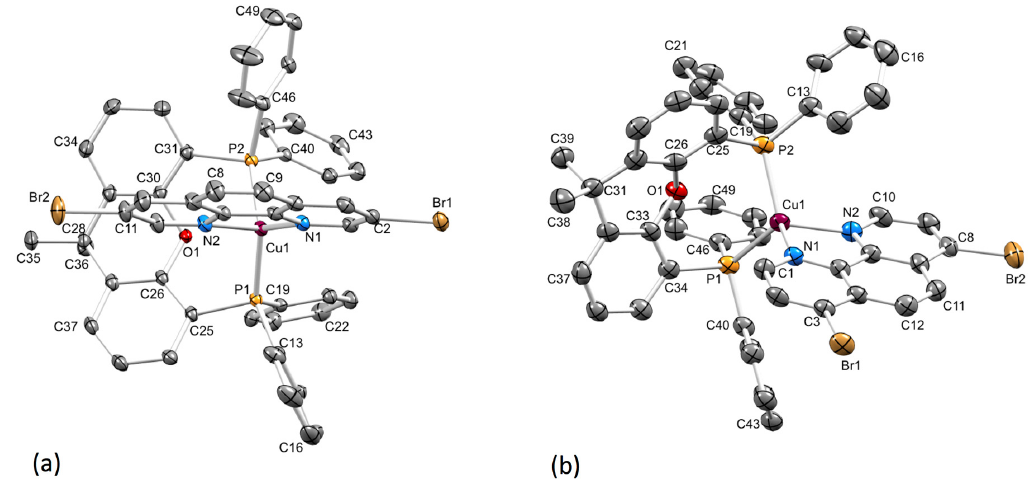
Figure 2. The structures of the POP-containing cations with H atoms omitted. ( a ) [Cu(POP)(2,9-Br 2 phen)] + (ellipsoids plotted at 50% probability), ( b ) [Cu(POP)(3,8-Br 2 phen)] + (ellipsoids plotted at 40% probability) and ( c ) [Cu(POP)(4,7-Br 2 phen)] + (ellipsoids plotted at 50% probability). In [Cu(POP)(2,9-Br 2 phen)][PF 6 ] · 0.5Et 2 O and [Cu(POP)(4,7-Br 2 phen)][PF 6 ] · CH 2 Cl 2 , there are two independent ions pairs in the asymmetric unit and only one cation is shown (see also Table 1 and the accompanying discussion).